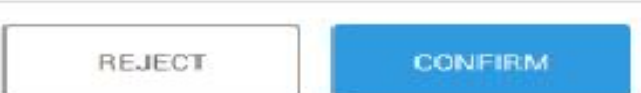
Figure 12. System veri fies user’s wallet balance.